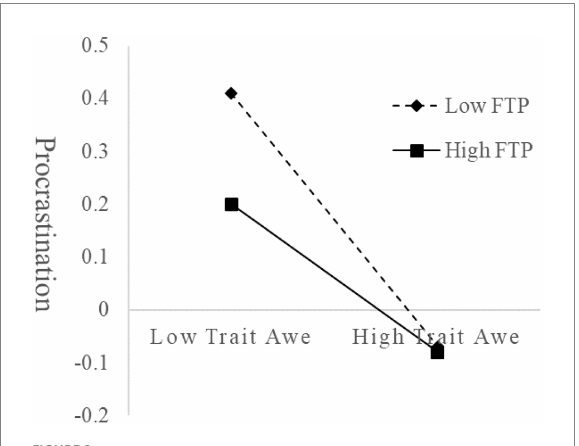
FIGURE 2 The moderating role of FTP in the relationship between trait awe and